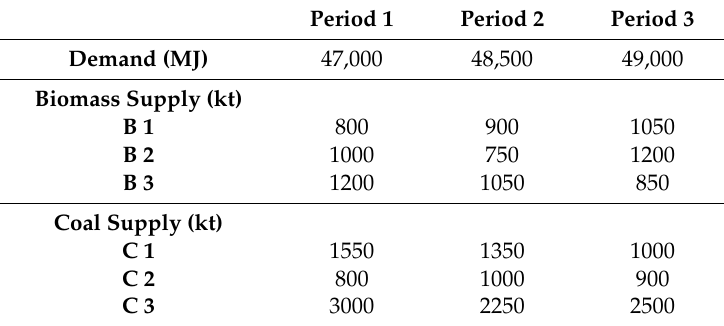
Figure 2. Solution Time of Varying Model Sizes. Table 2. Supply and Demand Parameters.